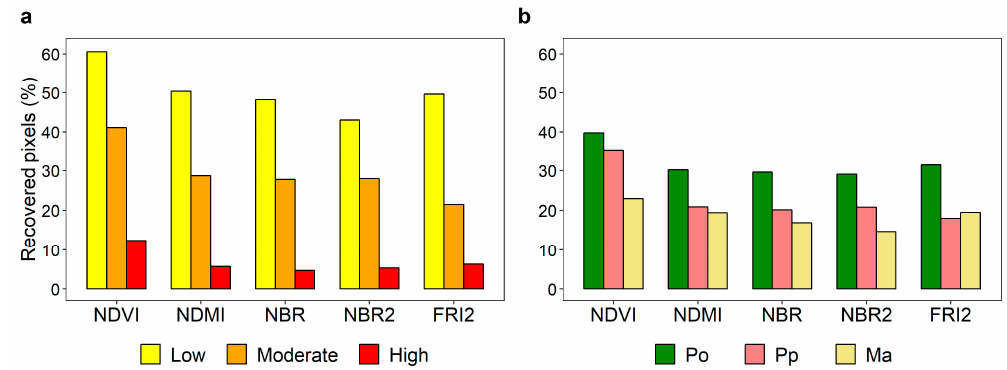
Figure 4. Percentage of recovered pixels aggregated by burn severity class ( a ) and forest type ( b ). Po: pubescent oak; Pp: pine plantations; Ma: mixed manna ash and European